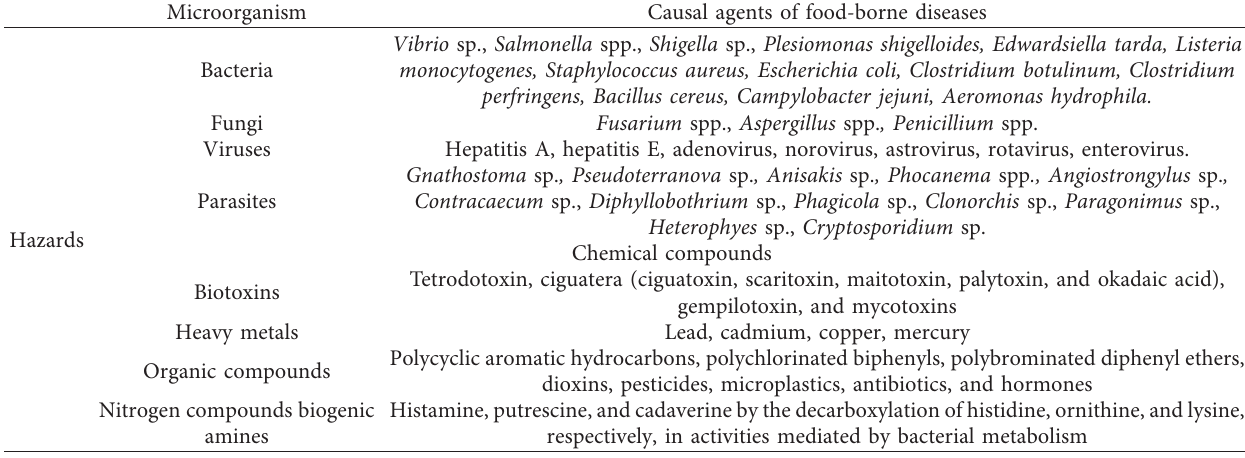
Table 1: Different hazards to the safety of fish and fish products intended for human consumption [22–25]. Microorganism Causal agents of food-borne